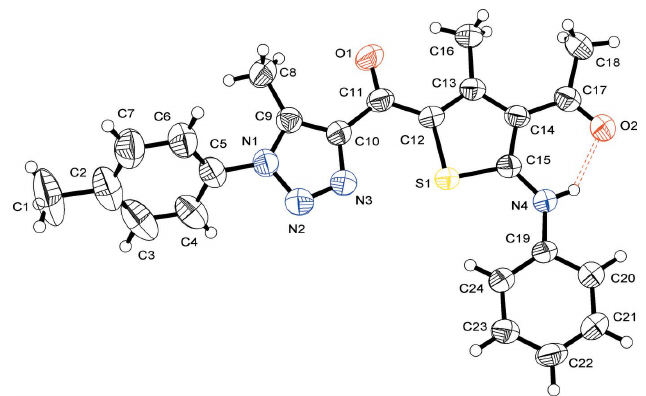
Table 1 Hydrogen-bond geometry (A˚ , (cid:2) ).